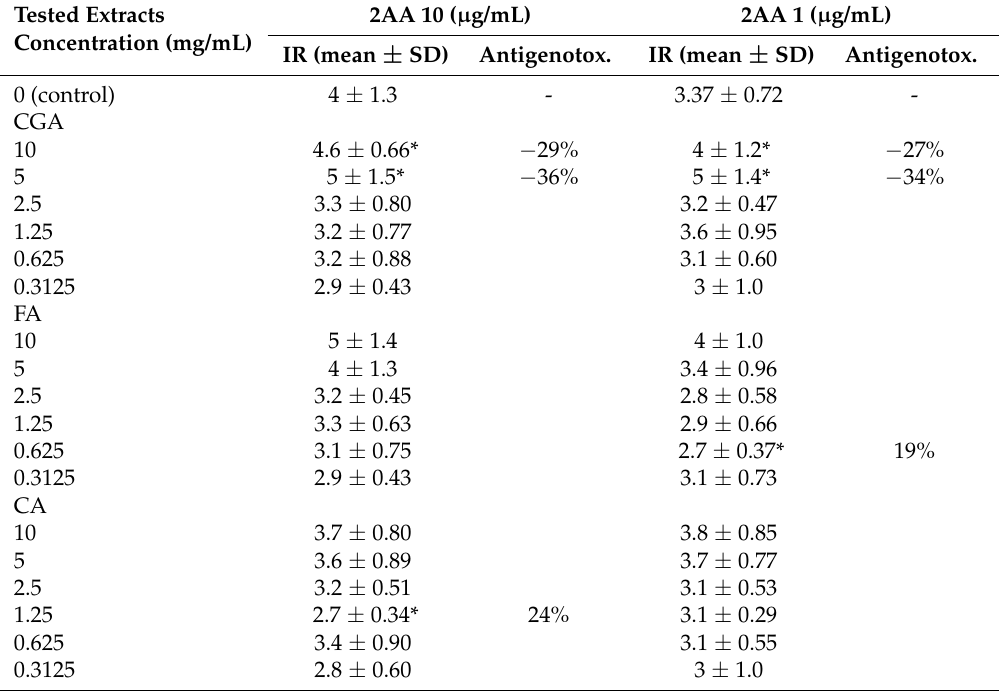
Table 6. Evaluation of antigenotoxic activity based on IR values for the control—genotoxins 2AA—and the mixture of genotoxins with PhAs.